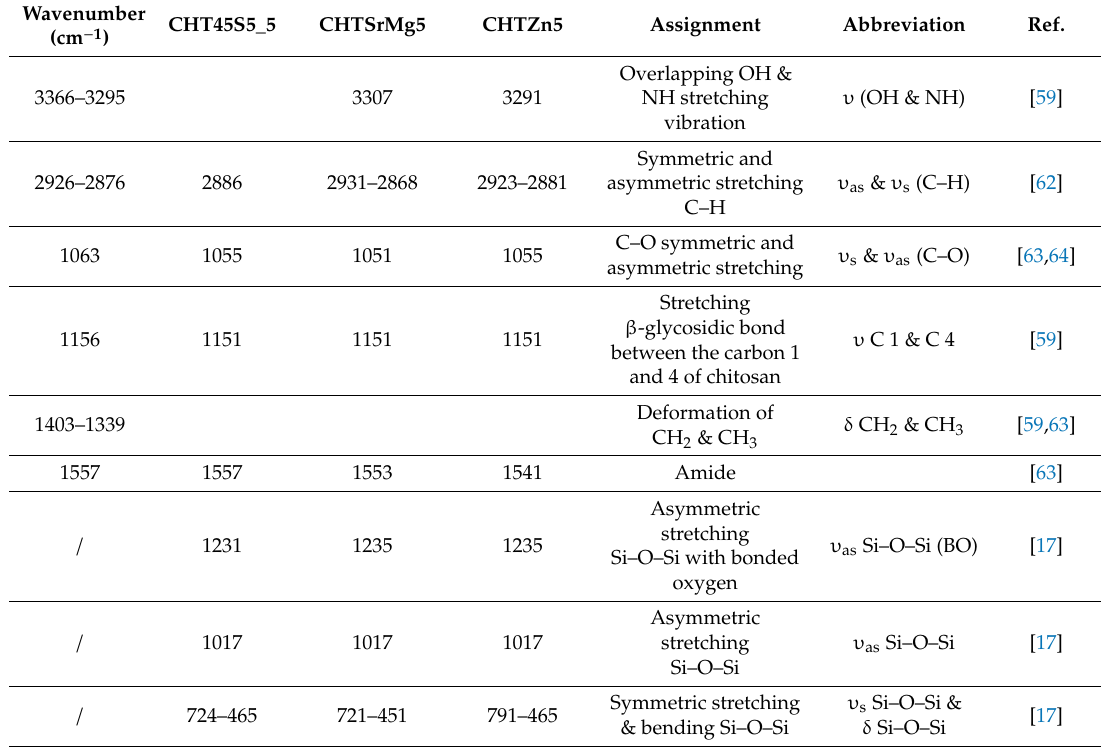
Table 3. Overview of the main bands detected in FTIR spectra of wound dressings.